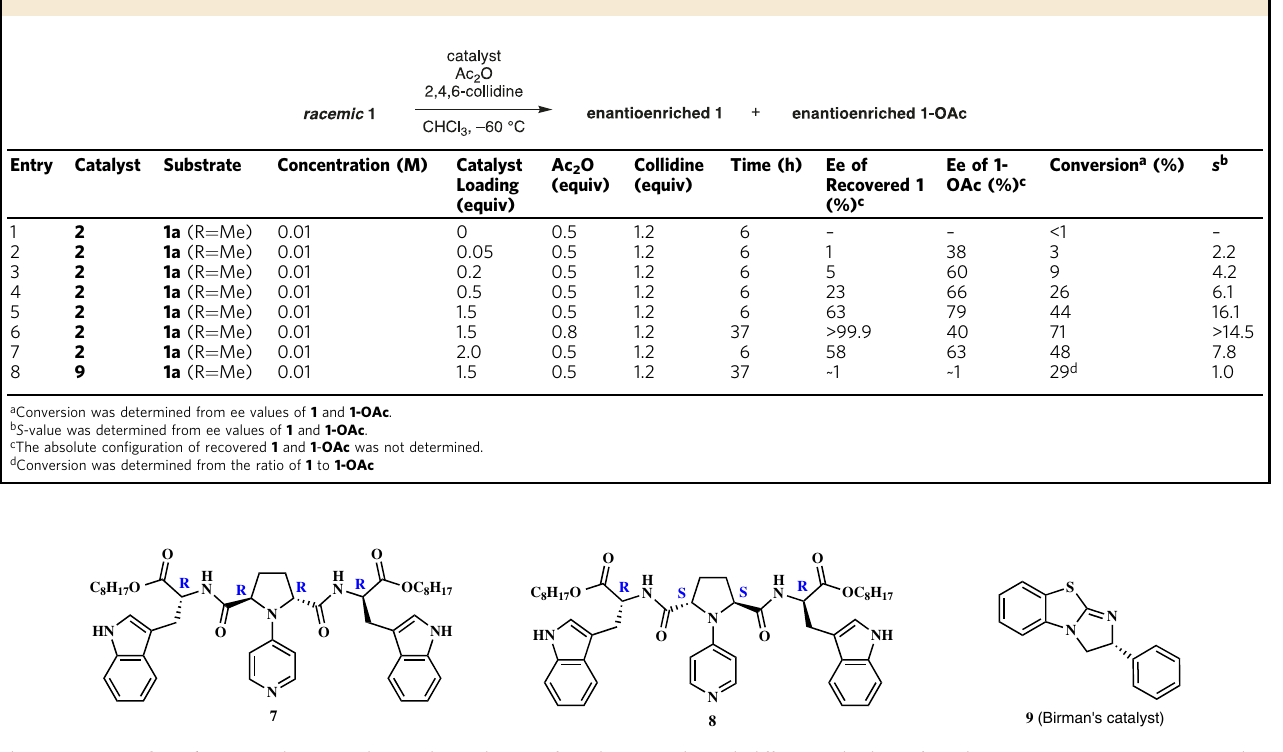
Table 2 Kinetic resolution of racemic rotaxane 1a: effects of catalyst loading and Birman ’ s catalyst on the selectivity of kinetic resolution of 1a at 0.01 M substrate